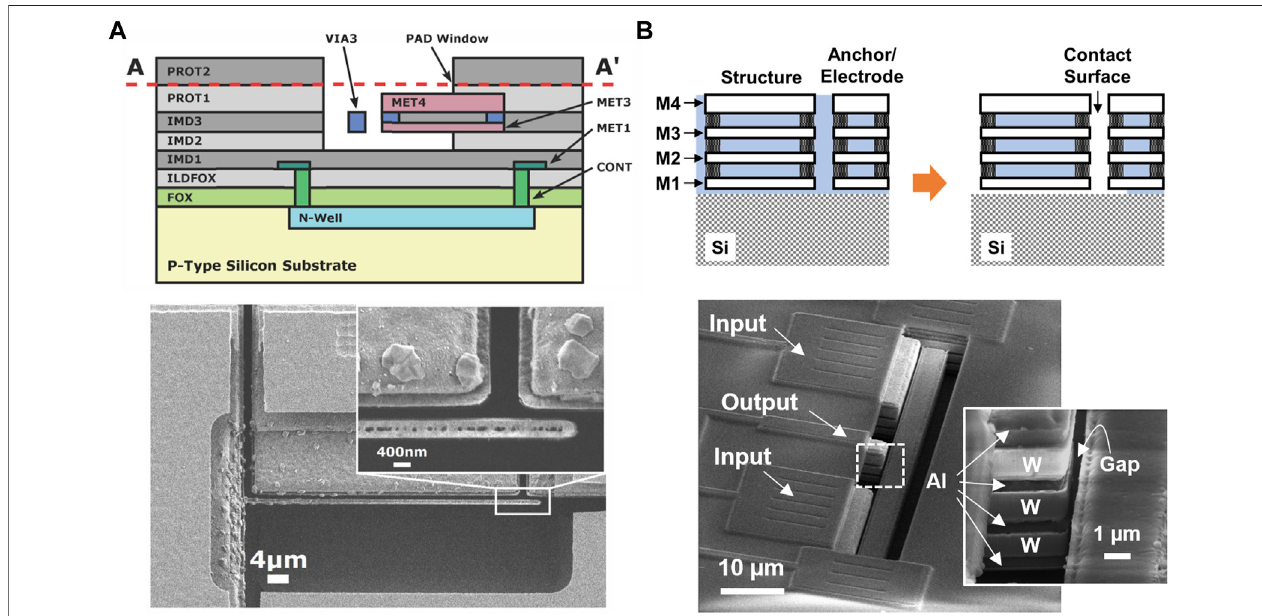
FIGURE 1 | CMOS-MEMS relays and resoswitches. (A) SEM and schematic of CMOS-MEMS tungsten VIA cantilever relay of Riverola et al. (2014). (B) Tungsten and aluminum stacking CC-beam resoswitch of Lu et al. (2018a). Reproduced from Riverola et al. (2014) and Lu et al. (2018a) with permission from IEEE.